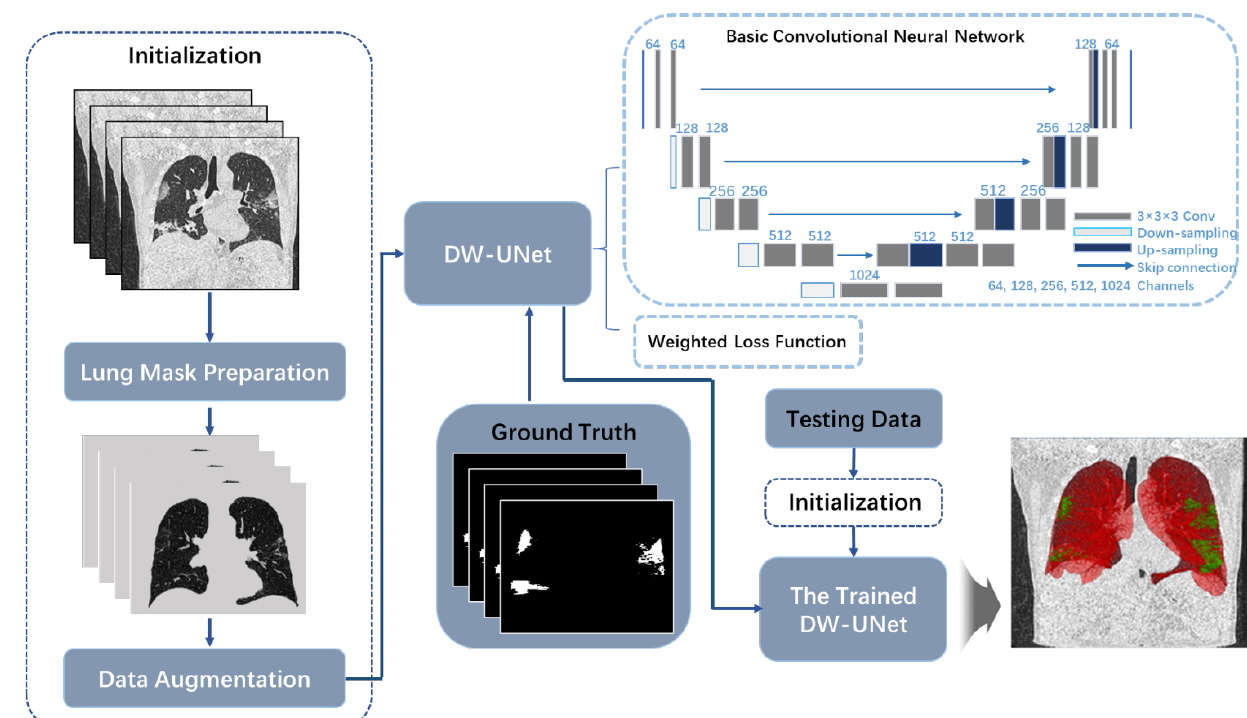
Figure 2. Method flow chart in this work.